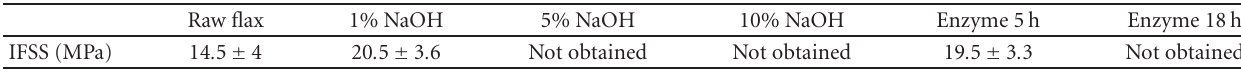
Table 2: Interfacial shear stress values of raw-, NaOH-, and enzyme-treated flax fibres calculated from microbonding test with a PLA